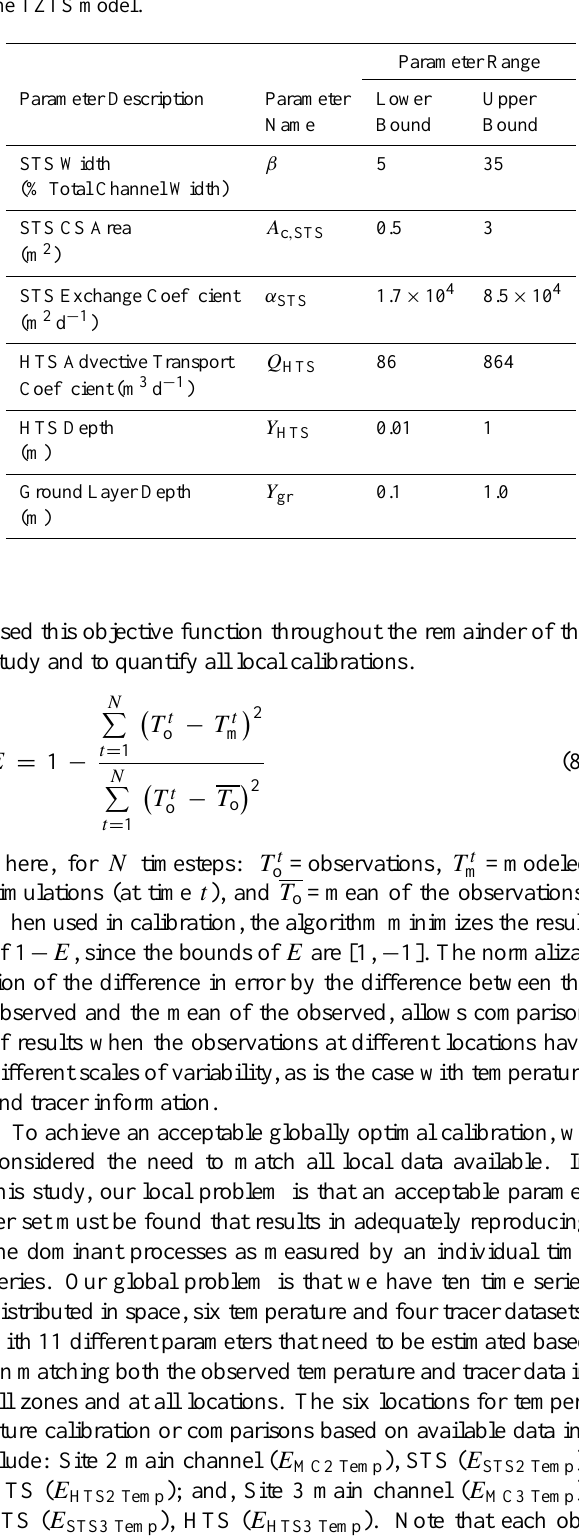
Table 2. A priori parameter range and calibrated parameter list for the TZTS